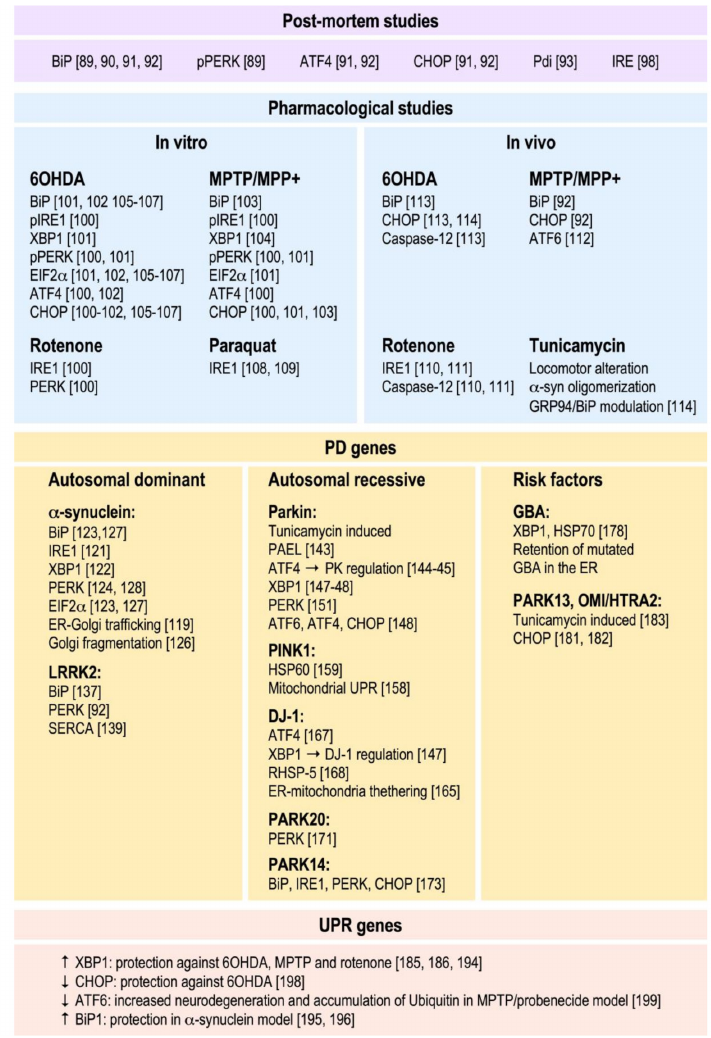
Figure 2. Evidence of the implication of UPR in Parkinson’s disease (PD) physiopathology demonstrated by post-mortem analysis and in vitro and in vivo pharmacological / genetic studies. Reference numbers are provided in